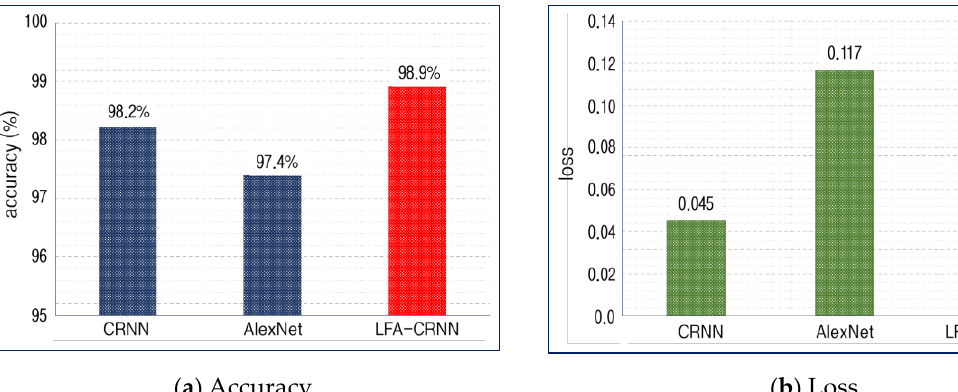
Figure 11. Accuracy and loss with the test data.